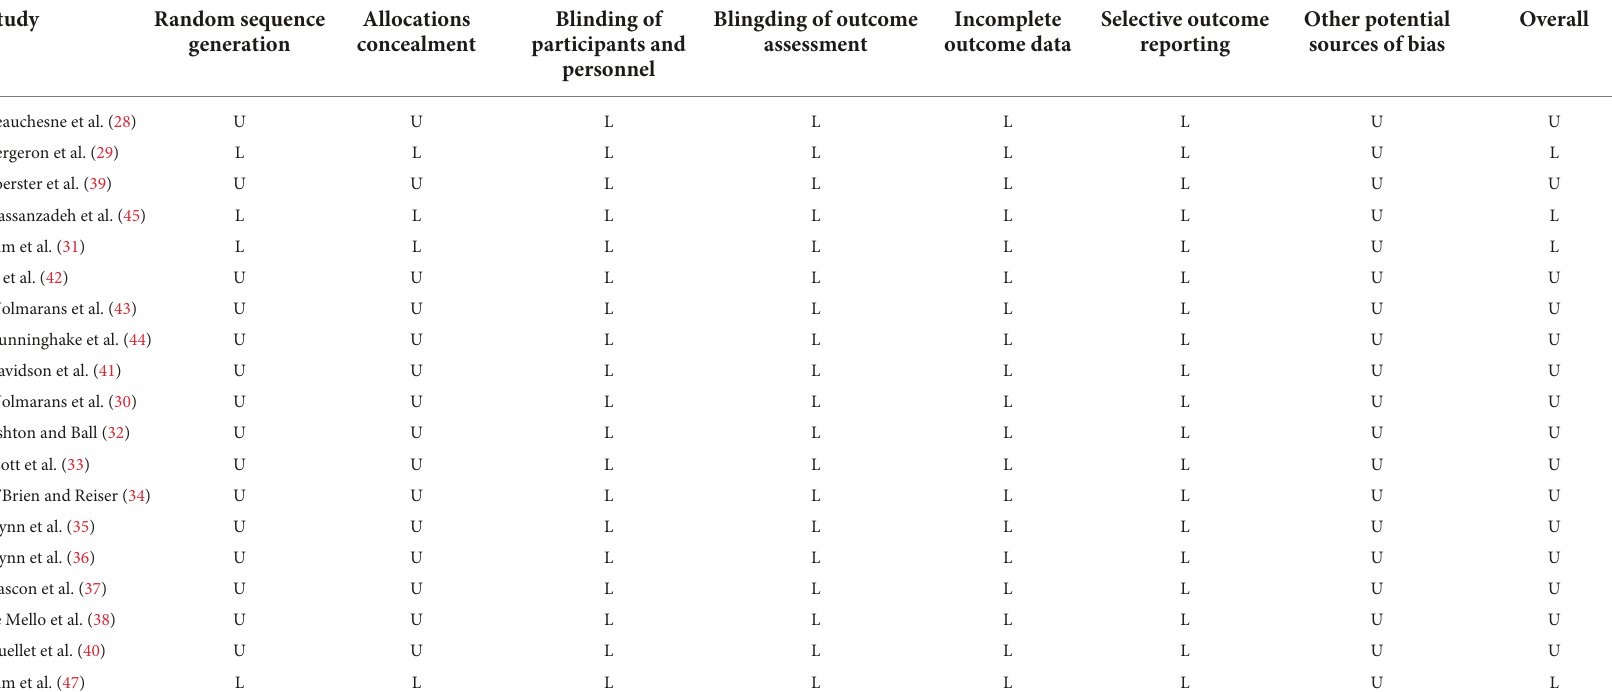
TABLE 5 Quality assessment of included